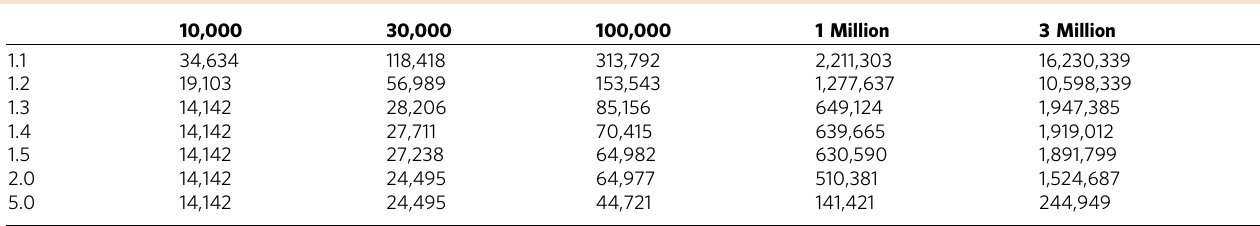
Table entries give the minimum number of cells that must be analysed in order to be able to detect a given fold-difference in species richness between two samples at P ¼ 0.05 (rowheadings), given an expected overall species richness (column headings). As noted in the main text, these numbers exclude cells that might belong to large clones (here, of clone size Z 30 in the sample). Minima required for reliable reconstructions are in grey. See Supplementary Methods for details.